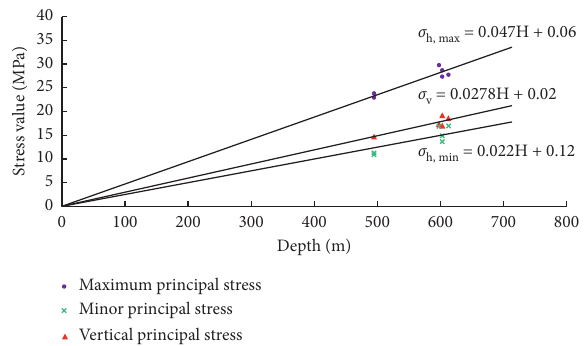
Figure 8: Relationship of σ h, max , σ h, min , and σ v to